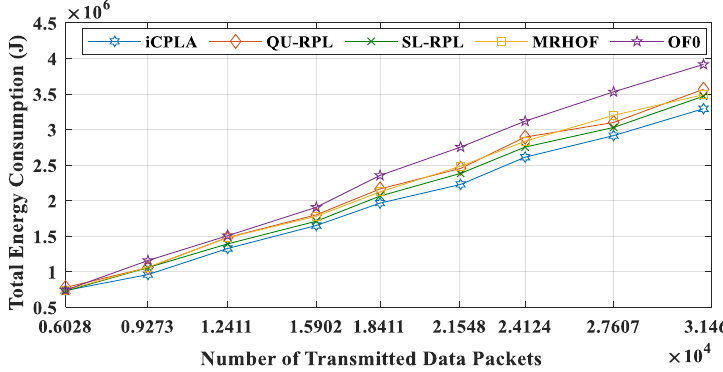
Figure 16. Total energy consumption (J) versus number of transmitted data packets for i CPLA, QU- RPL, SL-RPL, MRHOF, and OF0 with 𝛼 = 0.3 and 𝛽 = 0.7.